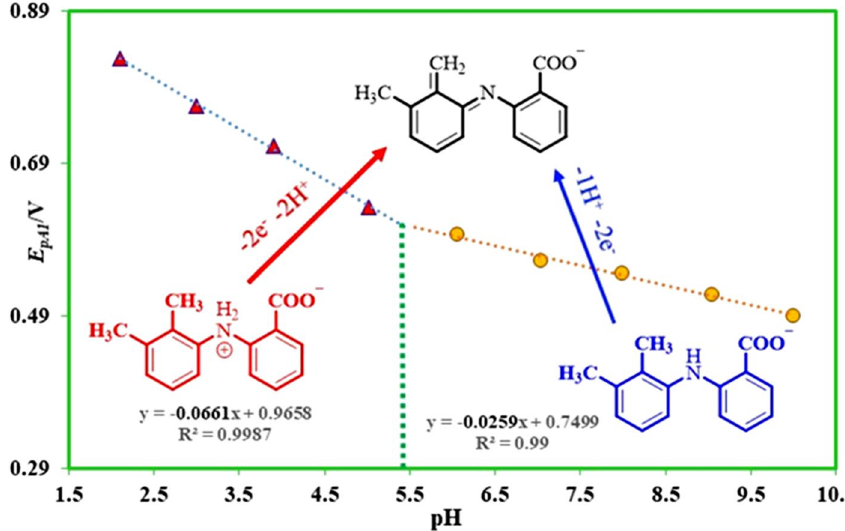
Figure 3. The potential-pH diagram of MFA .